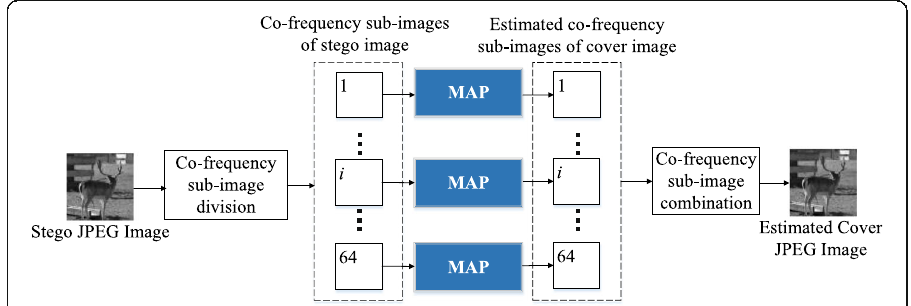
Fig. 5 The optimal cover JPEG image estimation method based on the first-order cover probability model of